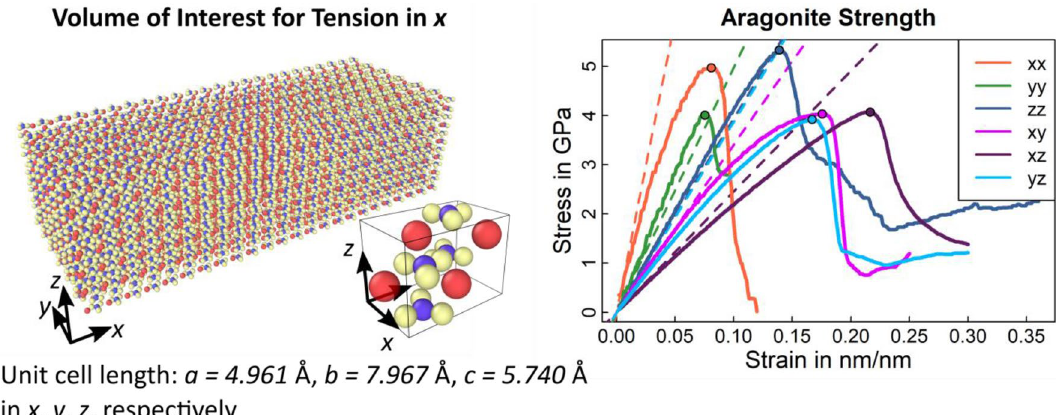
Figure 3. Aragonite stiffness and strength: An aragonite volume of interest with 24 × 6 × 6 unit cells of b c was used to determine crystal strength. The left image shows the setup used in the tensile dimension a × × tests along x and an animation of this test is shown in Video S1 and S2 (supplementary material). The model was verified against experimental stiffness values (Table 1) before conducting the strength test whose results are shown on the right. Maximum bearable stress is indicated by solid circles in each stress–strain curve in the image on the